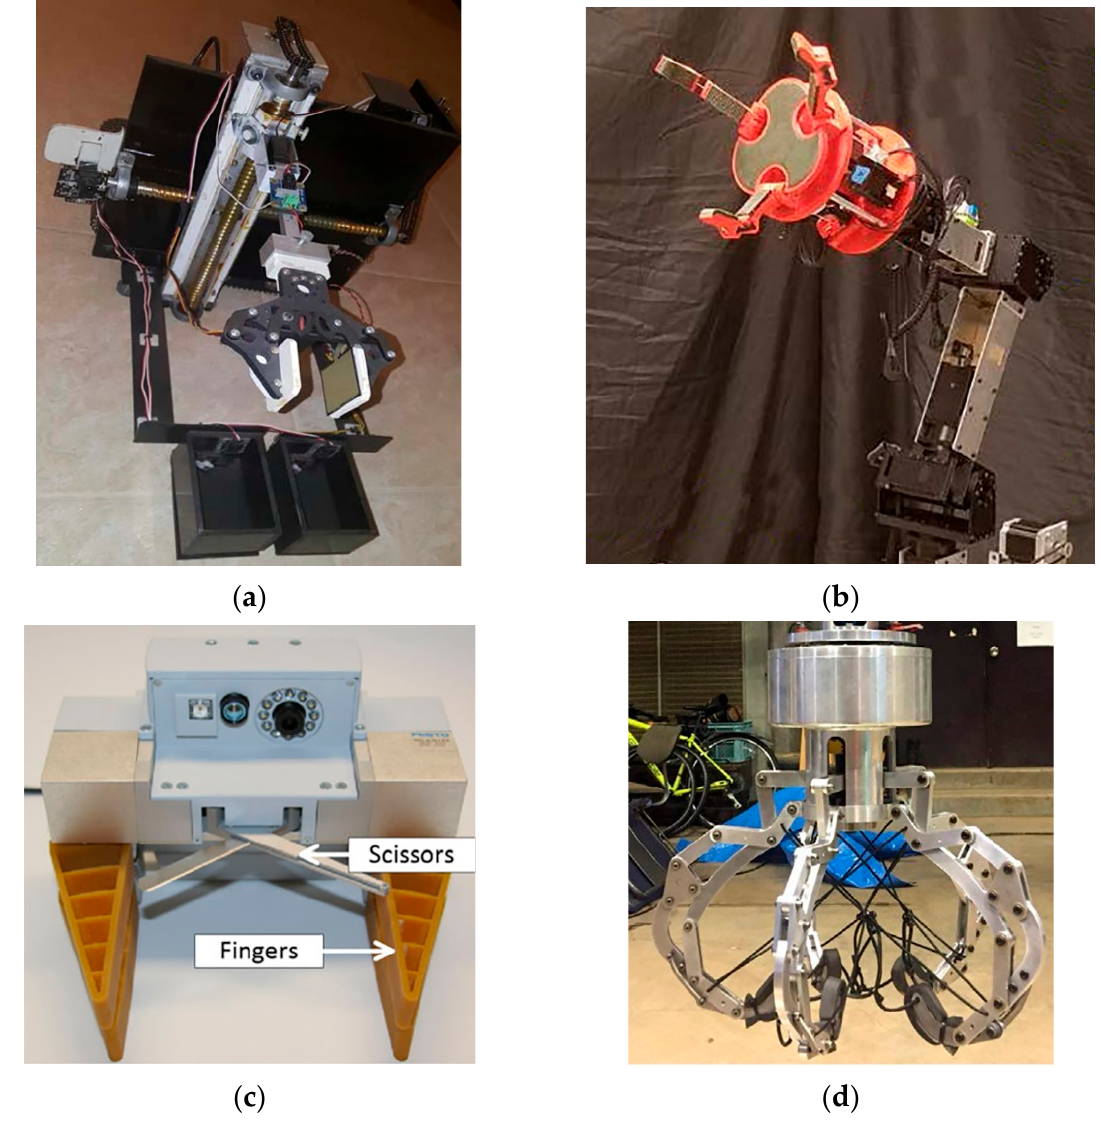
Figure 4. Multifinger grippers: ( a ) two-finger gripper (Reprinted/adapted with permission from Ref. [16]. 2017, Taqi, F.), ( b ) three-finger gripper (Reprinted/adapted with permission from Ref. [32]. 2017, Davidson, J.R.), ( c ) four-finger gripper (Reprinted/adapted with permission from Ref. [19]. 2017, Bac, C.W.) and ( d ) five-finger gripper (Reprinted/adapted with permission from Ref. [33]. 2020, Roshanianfard, A.).